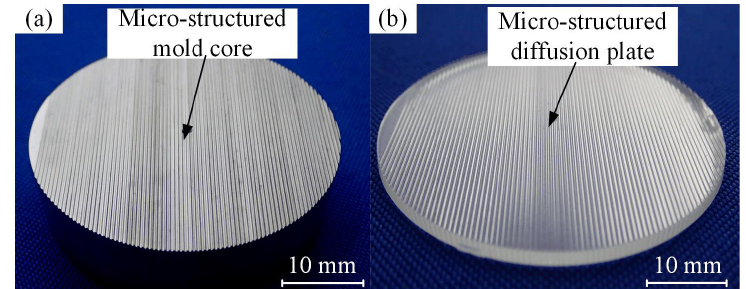
Figure 9. Photographs of the micro-structured mold core and diffusion plate: ( a ) micro-ground mold core; ( b ) injection molded diffusion plate sample.